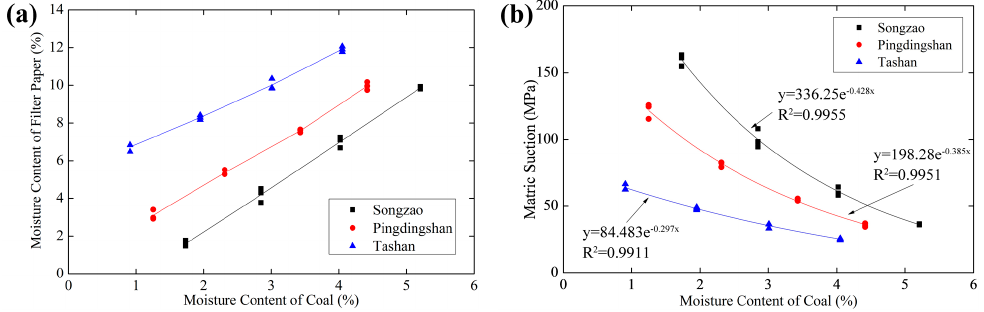
Figure 5. ( a ) Moisture contents of filter papers; ( b ) Fitted relationship curves of matrix suction and moisture content.